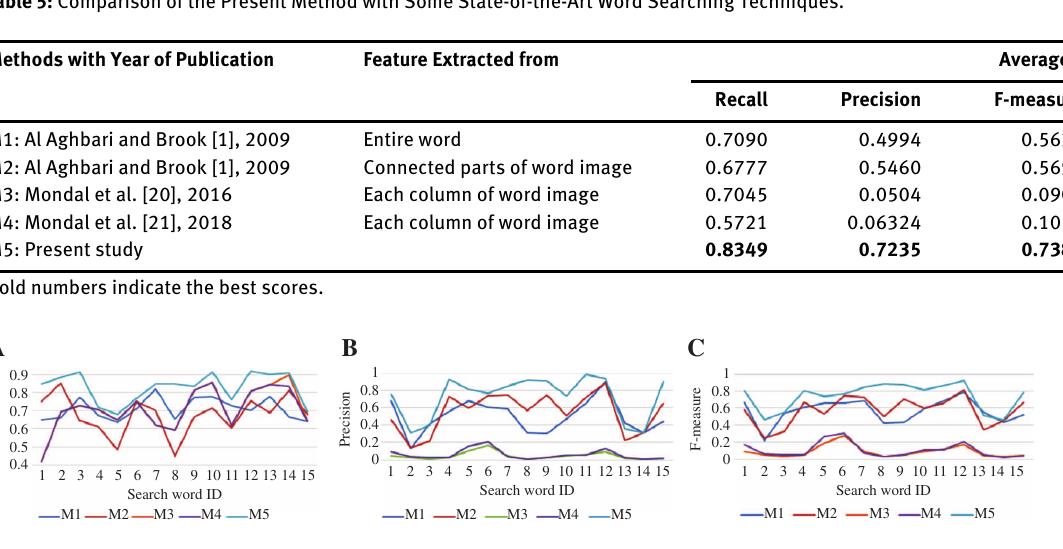
Figure 9: Search Word-Wise Evaluation Metrics of Different